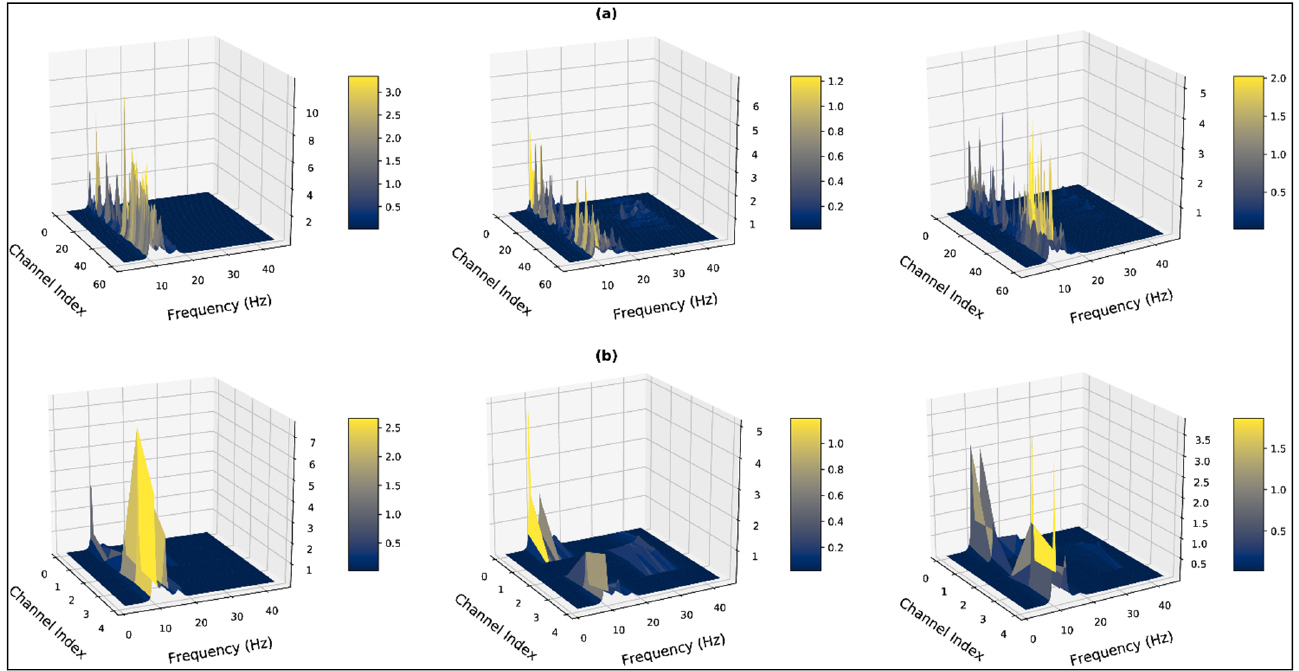
Figure 9. Three-dimensional visualization of the computed MUSIC spectrum for the negative state ( left ), the neutral state ( middle ), and the positive state ( right ) of subject:12, trial: 14 ( a ) considering all 62 channels ( b ) excluding the corrupt channels before channel reduction.